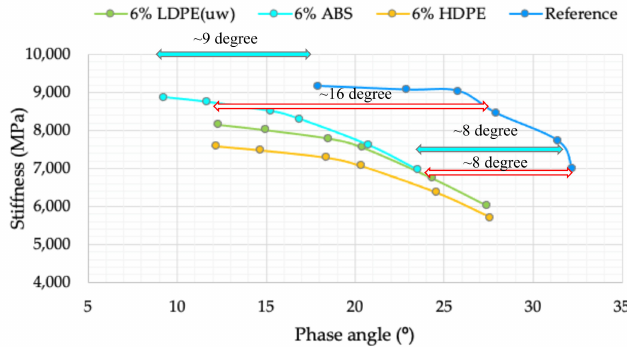
Figure 16. Black diagram derived from four-point bending tests at 20 ◦